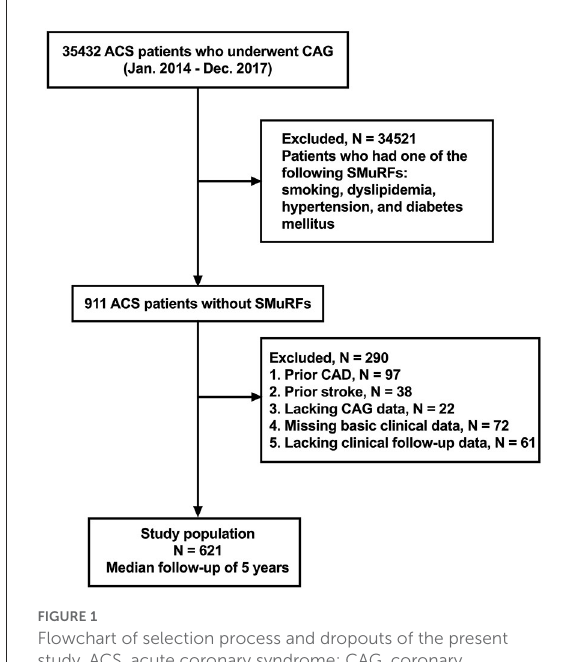
FIGURE1 Flowchart of selection process and dropouts of the present study. ACS, acute coronary syndrome; CAG, coronary angiography; SmuRFs, standard modifiable cardiovascular risk factors; CAD, coronary artery